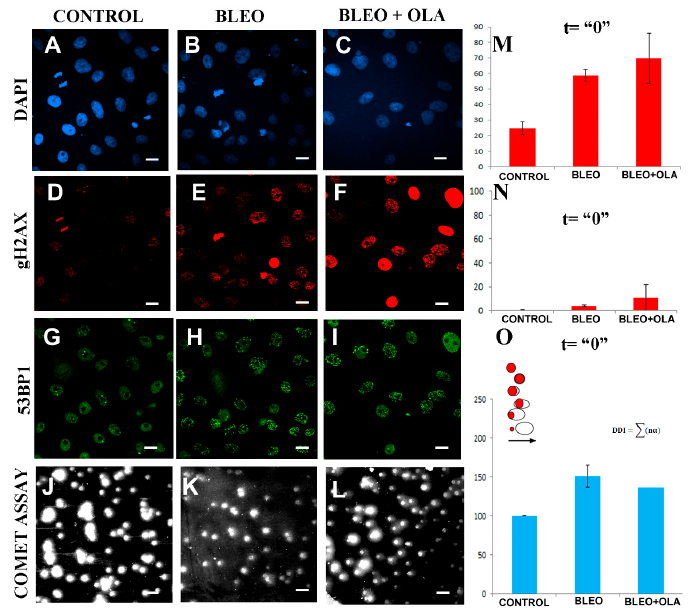
Figure 4. OLA did not hamper the DNA damage induction by BLEO. The initial (t = ”0”) BLEO- induced DNA damage in the presence or absence of the OLA co-treatment was evaluated All images and graphs follow the order: Control, BLEO and BLEO+OLA, from left to right. ( A – I ) Representative follow the order: Control, BLEO and BLEO + OLA, from left to right. ( A – I ) Representative ICF images. ICF images. ( A – C ): DAPI in blue; ( D – F ): gH2AX in red; ( G – I ): 53BP1 in green. ( J – L) Representative single-cell electrophoresis or comet assay images ( M, in red): Percentage of cells with a γ H2AX foci. Data were from three independent experiments and n ≥ 200 cells/condition. Two-tailed t -test. ( N, in red) Pan-nuclear γ H2AX cells were counted on the same set of images. ( O , in blue) The comet assay was evaluated using the DNA damage index (DDI). In turn, the results were normalized to control the DDI to pool the experiments. Data were from three independent experiments, with n ≥ 140 cells/condition. Two-tailed t -test. p = 0.17 (control vs. BLEO), p = 0.099 (control vs. BLEO + OLA), p = 0.24 (BLEO vs. BLEO + OLA). To calculate the DDI, each comet was assigned a degree from 1 to 5. The inset scheme represents comet heads (in red) and comet tails (in white) for successive degrees. 1: